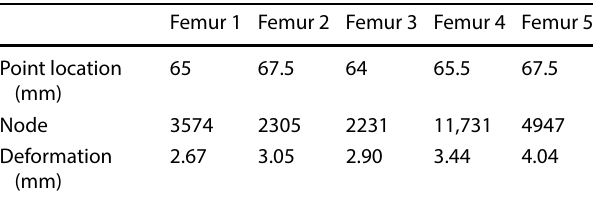
Table 2 Point and node location of the application of deformation in each finite element model